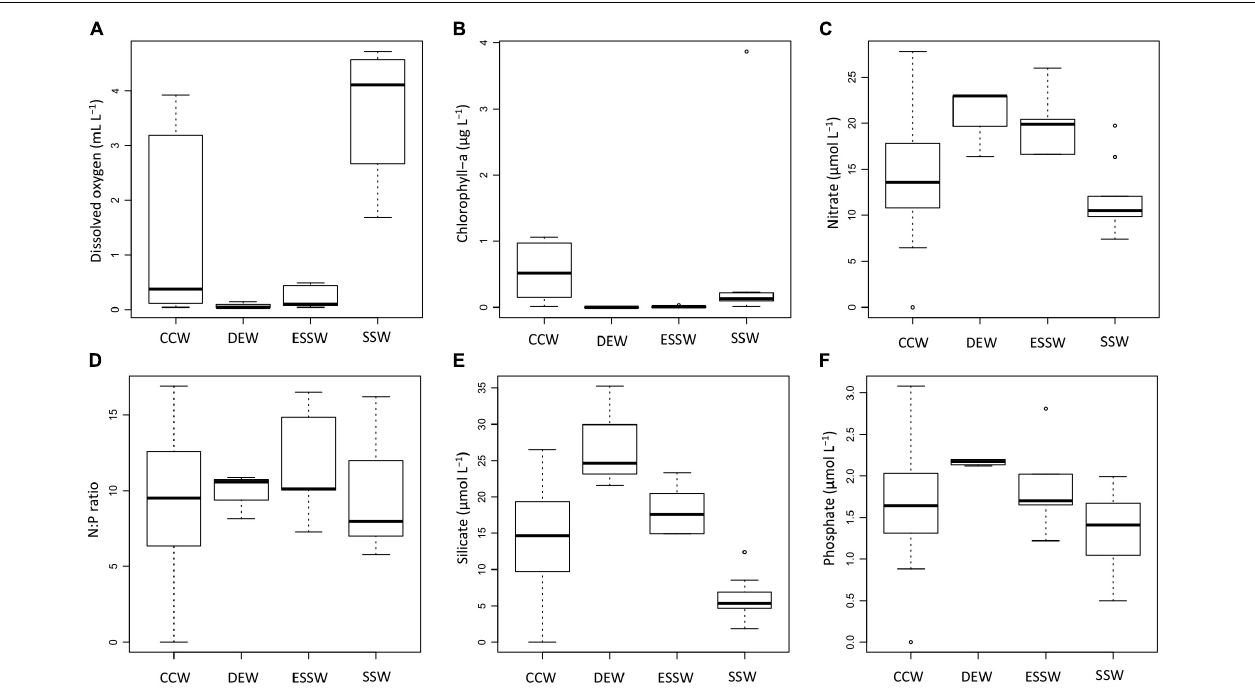
FIGURE 3 | Box plots of chemical properties for the studied transect during 2015. Properties depicted are: dissolved oxygen (A) , chlorophyll-a (B) , nitrate (C) , N:P ratio (D) , silicate (E) , and phosphate (F) . CCW: Coastal Cold Waters ( n = 22), DEW: Deep Equatorial Waters ( n = 4), ESSW: Equatorial Subsurface Waters ( n = 6), SSW: Surface Subtropical Waters ( n = 15).